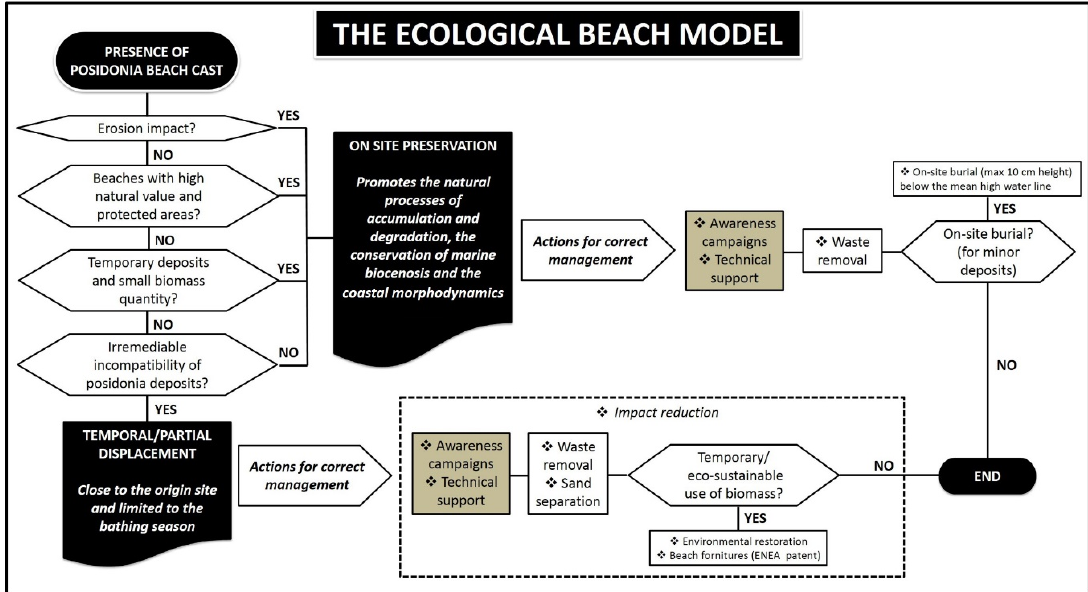
Figure 2. Flowchart of the sustainable management of posidonia beach-casts according to the Ecological Beach model (modified from [5] ).